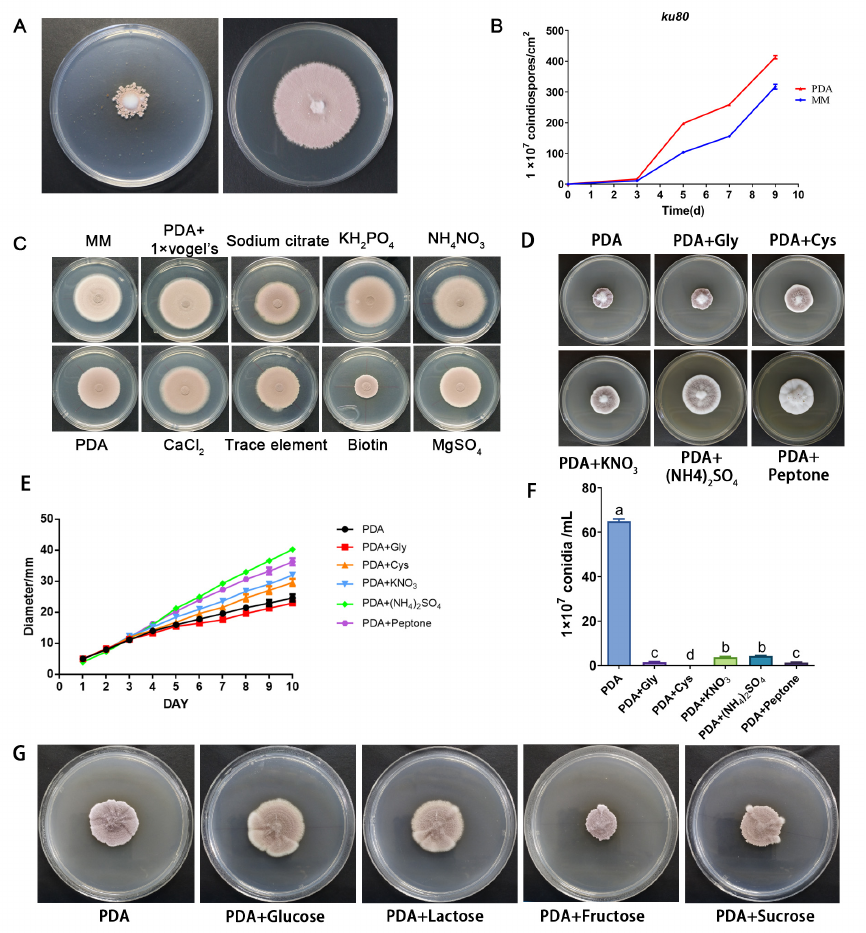
Figure 1. NH 4 NO 3 affects the growth and conidiation of P. lavendulum. ( A ) Comparison of colony morphology of the ku80 strain cultured on PDA ( left ) and MM ( right ) media for 10 days. ( B ) Conidiation comparison of the ku80 strain cultured on PDA ( left ) and MM ( right ) media for 10 days duration. ( C ) Comparison of colony morphology of the ku8 0 strain on MM, PDA, and PDA plus components from MM media. ( D ) Comparison of colony morphology of the ku80 strain on PDA and PDA with additional nitrogen sources. ( E ) Growth comparison of the ku80 strain (samples same as ( D )). ( F ) Conidiation comparison of the ku80 strain (samples same as ( D )). Different lowercase letters above columns indicate statistical differences as p < 0.05 according to ordinary one-way ANOVA test. ( G ) Comparison of colony morphology of the ku80 strain on PDA and PDA with additional carbon sources.